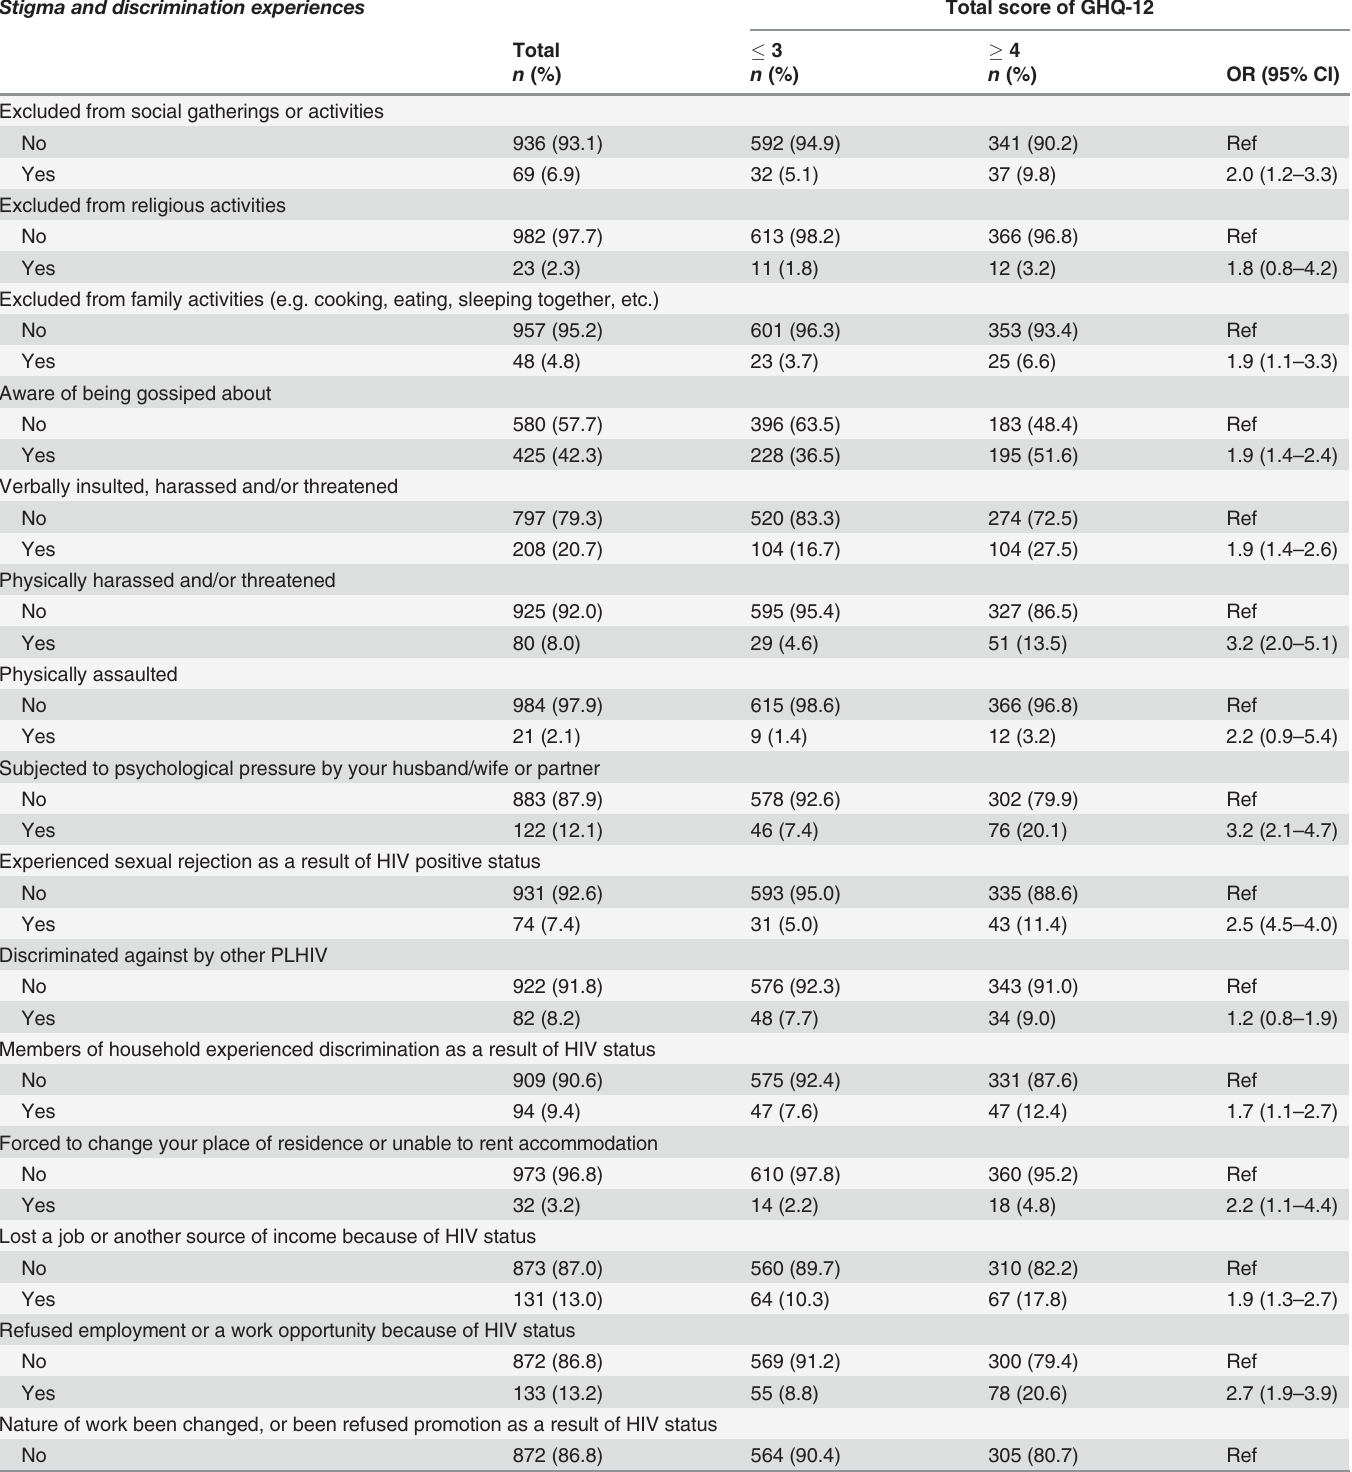
Table 2. Comparisons of stigma and discrimination experienced in communities in the past 12 months among PLHIV with lower and higher levels of mental